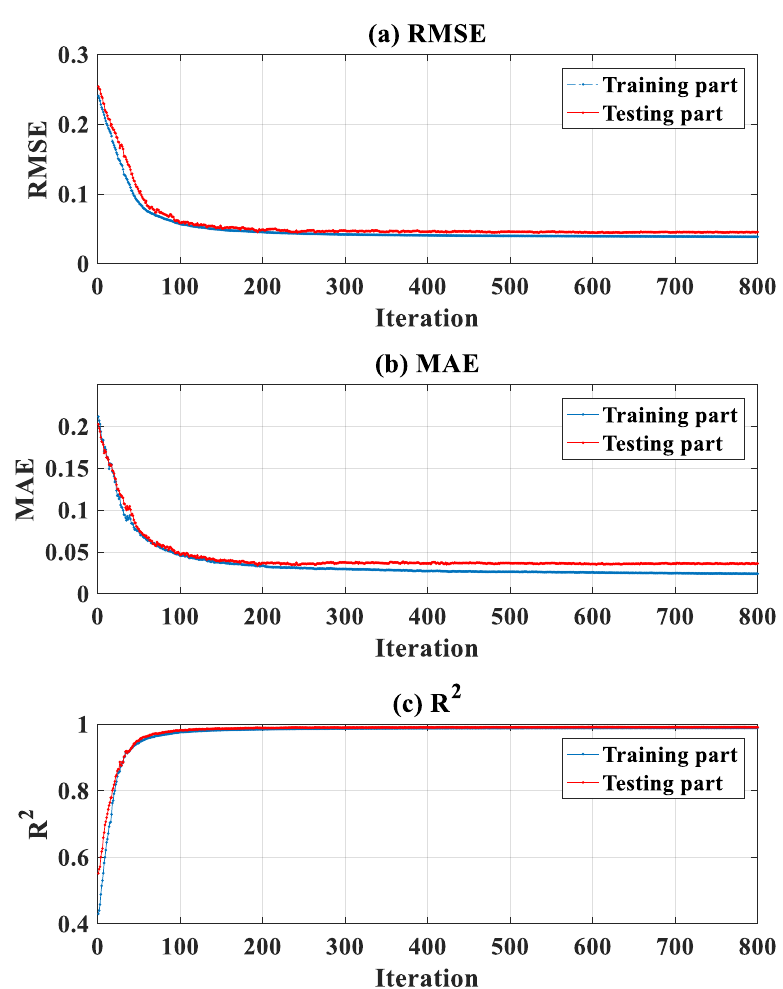
Figure 6. Evaluation of the performance indicators during optimization: ( a ) RMSE, ( b ) mean absolute error (MAE), and ( c ) R 2 , for training and testing data, respectively.